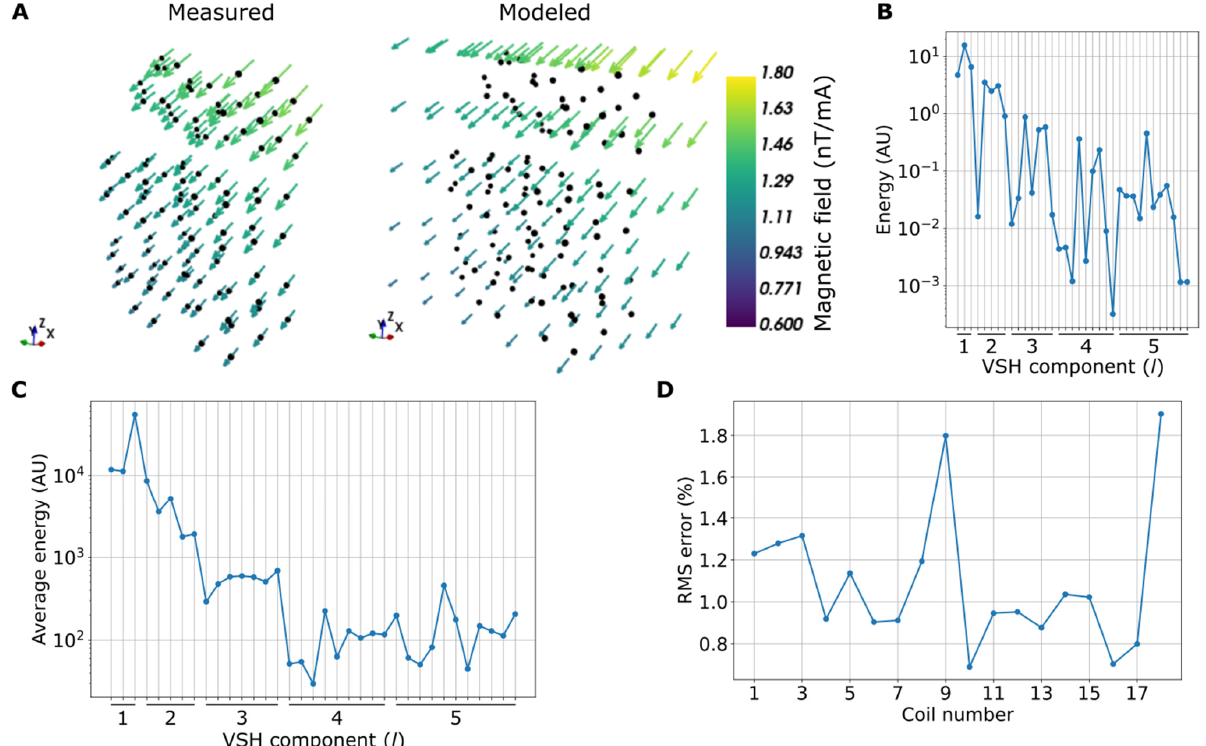
Figure 2. Fitting vector spherical harmonics (VSHs) to the measured magnetic field data: ( A ) Example of a coil magnetic field measured with a three-axis fluxgate at 108 points, together with its VSH fit, extrapolated to a volume surrounding the measurement points. The magnetic field values were normalized by the applied current. ( B ) Magnetic field spectrum of the coil field in panel A given by the squared VSH coefficients. The squared coefficients are shown for each degree l and its corresponding 2l + 1 orders. ( C ) Average magnetic field spectrum of the 18 shield coils. ( D ) Normalized RMS errors between the VSH fits and the